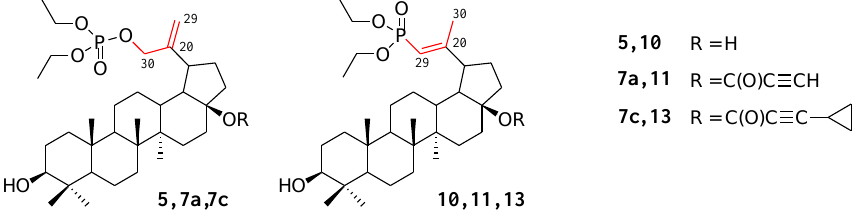
Figure 2. Structure of allyl substituted compounds 5 , 7a , and 7c (phosphate derivatives) and vinyl 10, 11, and 13 (phosphonate derivatives).